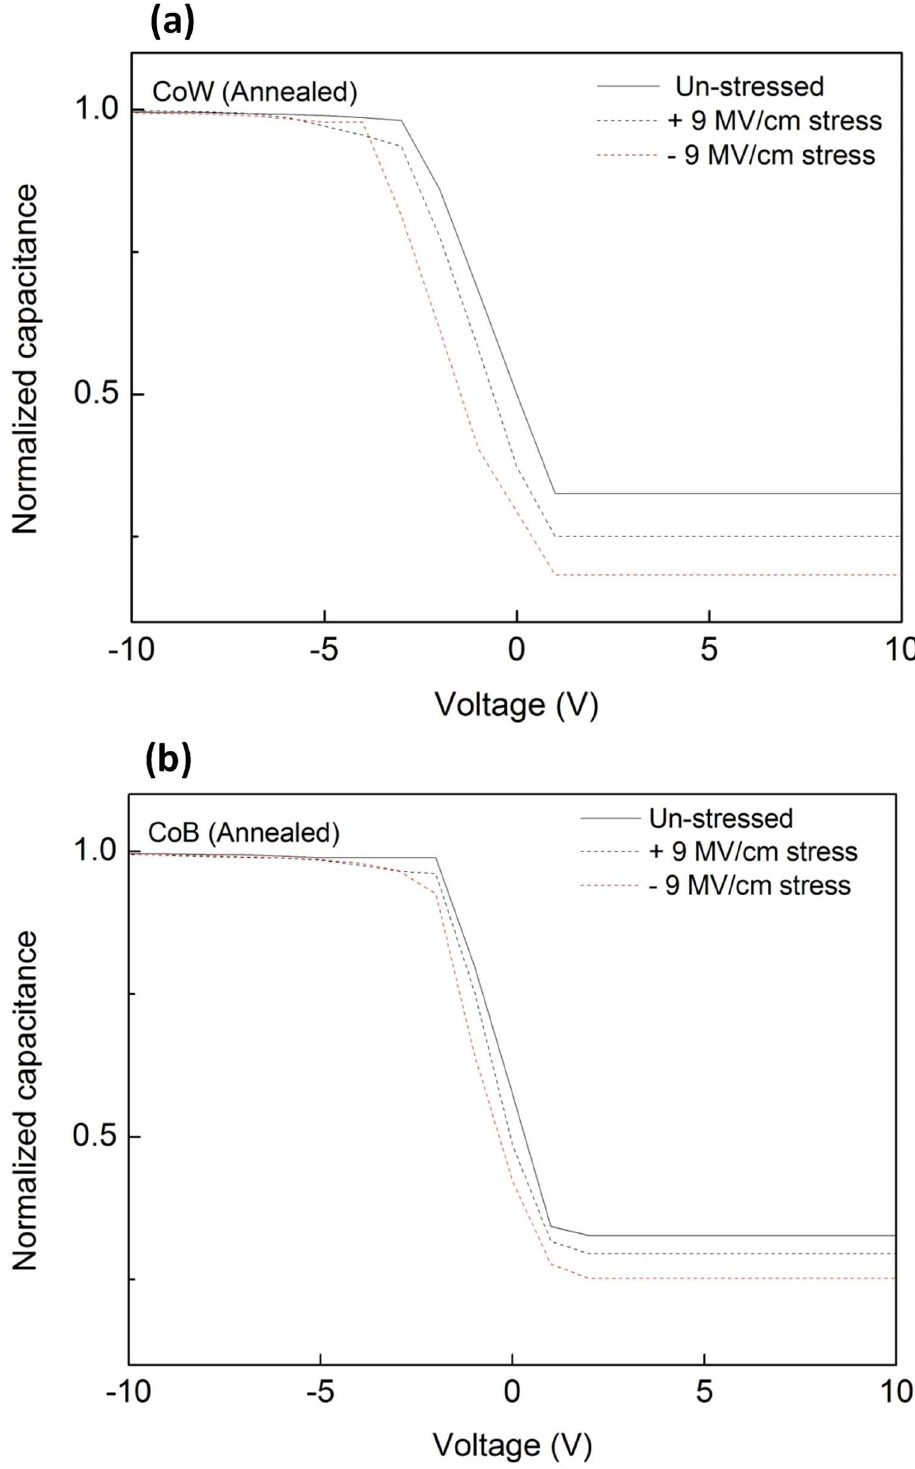
Figure 6. C-V curves of annealed MIS capacitors after electrical stress at ±9.0 MV/cm for 10 3 s; ( a ) CoW-gate; ( b ) CoB-gate.